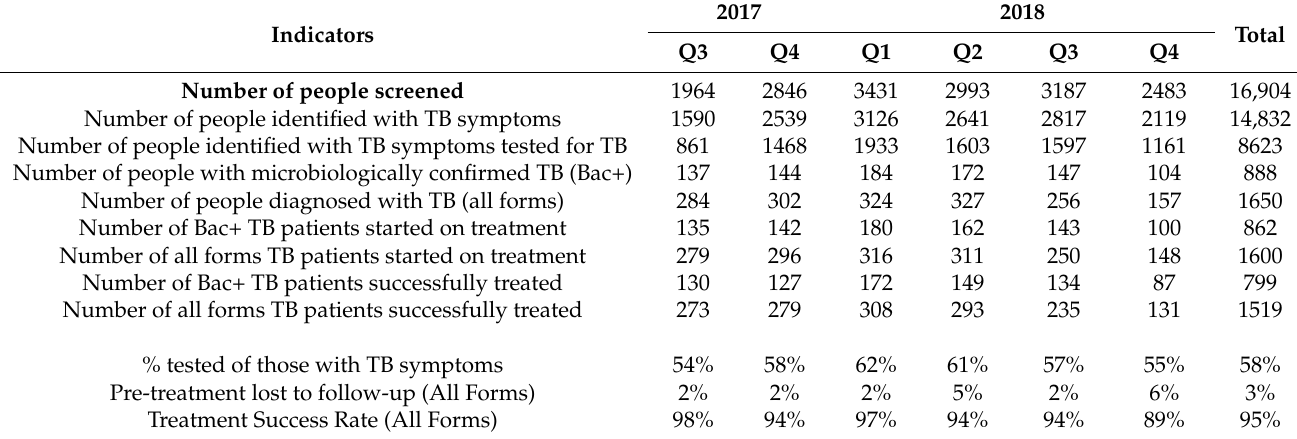
Table 1. Outcome in the public project between July 2017 and December 2018.